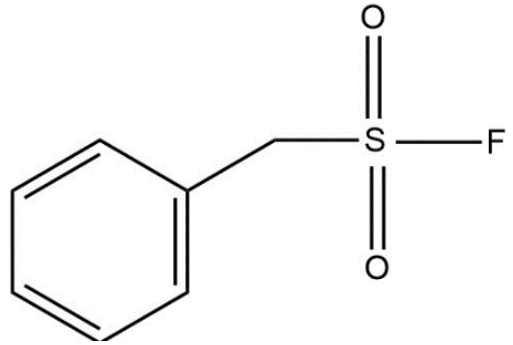
Figure 3. Molecular structure of PMSF.